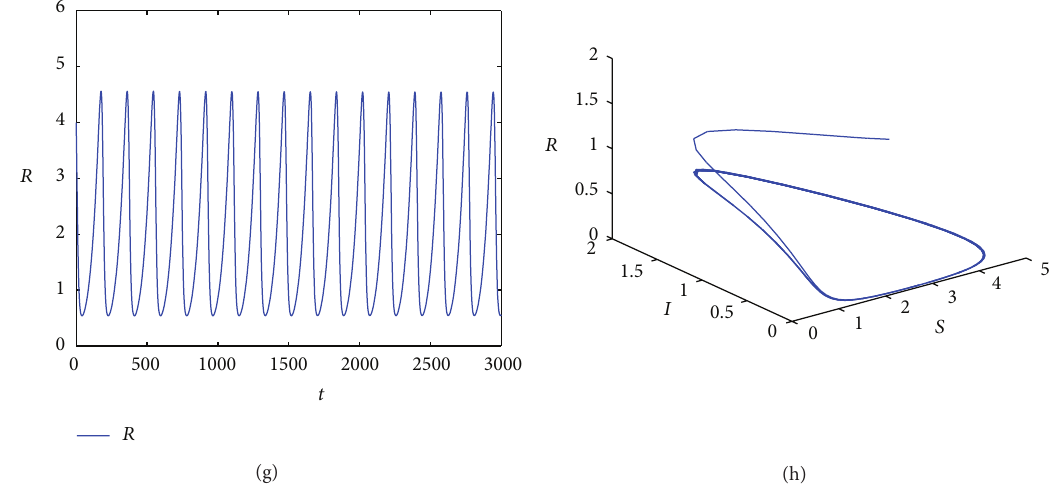
Figure 2: The numerical simulation graphics of system (1).